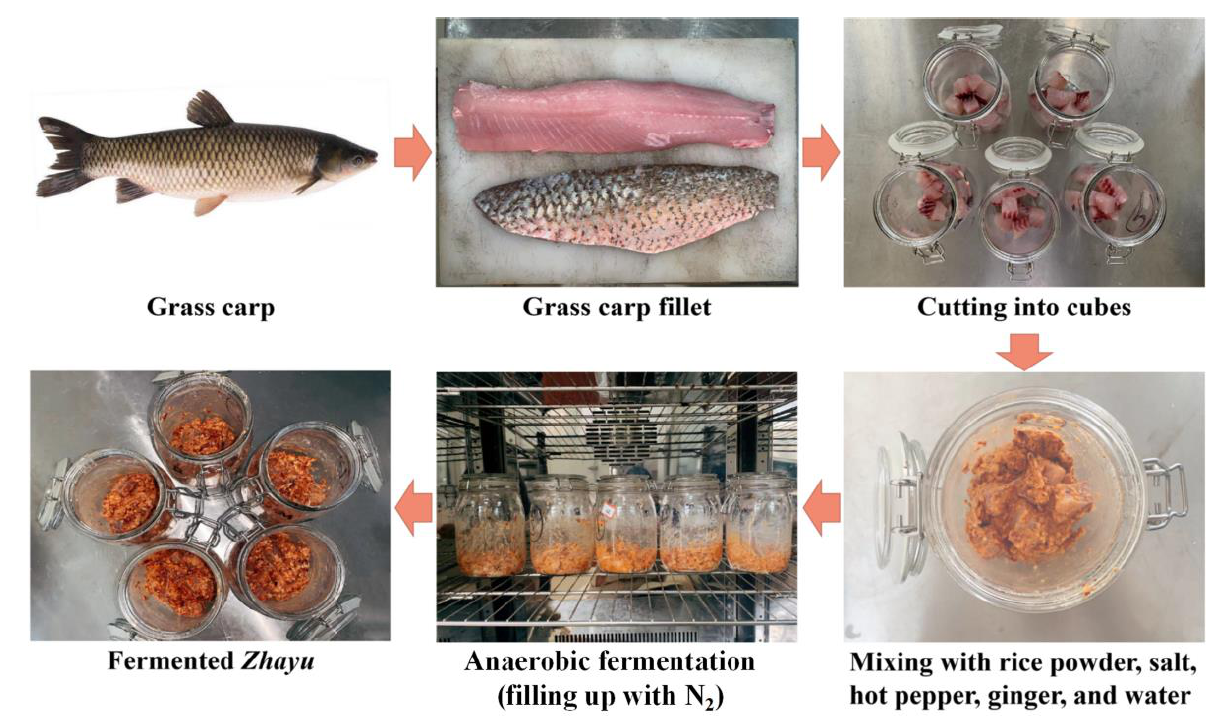
Figure 1. Schematic illustration for the process of fermented Zhayu products.